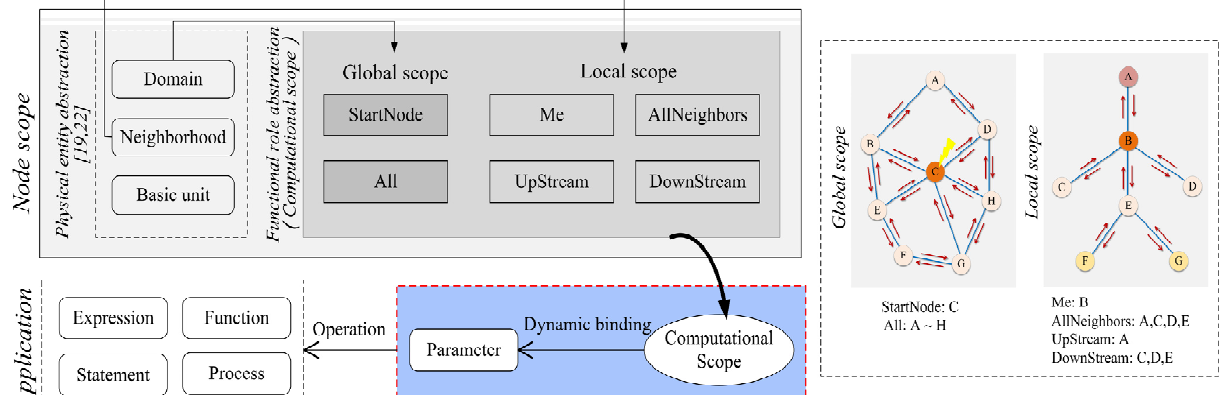
Figure 8. Computational scope diagram.